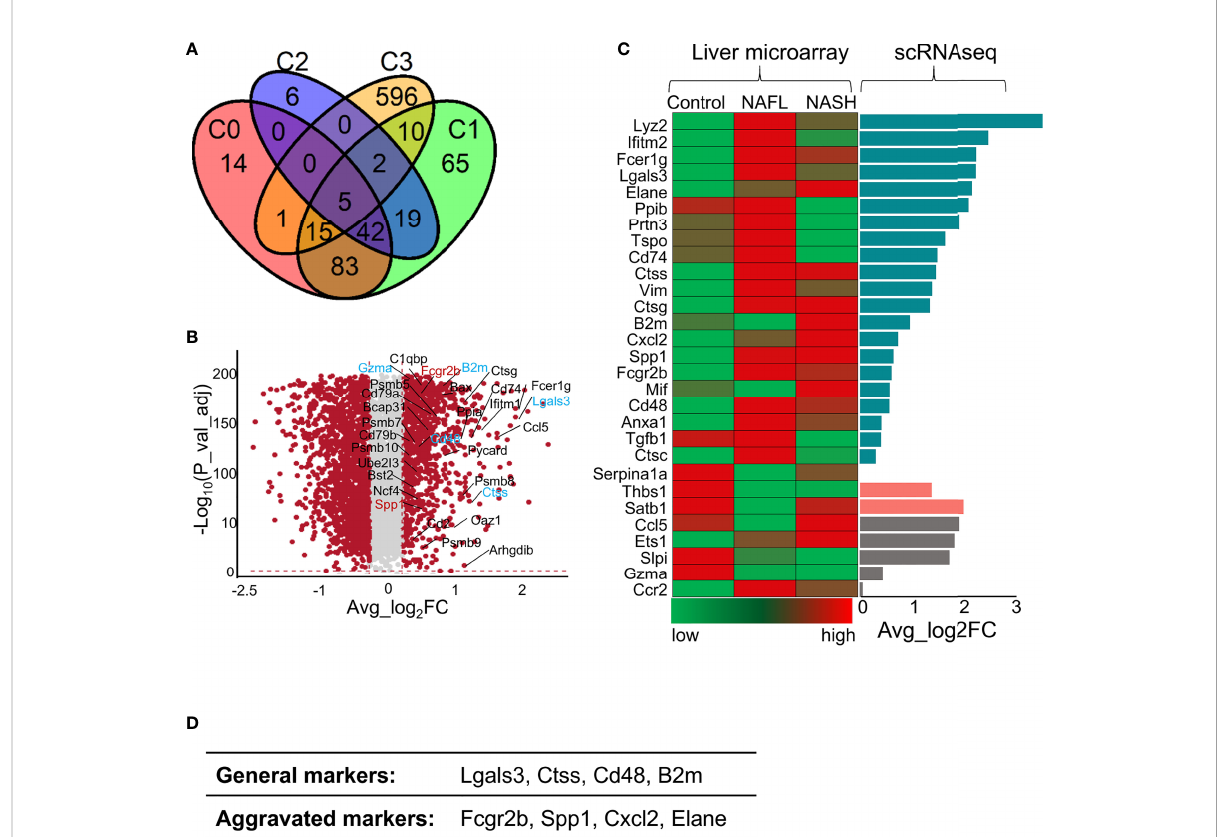
FIGURE 6 Comparison of gene pro fi le alterations during human NAFLD pathogenesis with mouse NAFL regulated by ApoA4 de fi ciency. (A) Venn diagram showing the overlap of upregulated genes identi fi ed in the KO group with genes identi fi ed in a cohort study by Michael et al. (2020) (36) ( P = 3.7e-11), as determined by a hypergeometric test. C0 was a set of differentially expressed genes between healthy controls and patients with mild liver steatosis, while C1 included genes upregulated in advanced liver steatosis compared with healthy controls. C2 consists of differentially expressed genes between patients with mild and advanced liver steatosis. C3 was upregulated in the KO group in this study. (B) Volcano plot showing differentially expressed genes in the KO group vs. WT group. Red dots indicate genes passing our P value -adjust and fold difference thresholds. Thirty-two genes that were crossed between C1 and C3 are marked with gene names, genes crossed between C2 and C3 are colored blue, and genes crossed among C1, C2 and C3 are colored red. (C) Comparison of the expression of genes of interest between NAFLD datasets (GSE63067) (left) obtained by liver microarrays and the data from this study obtained by scRNA-seq (right); Average_log 2 fold change > 0 in dark green, Average_log 2 fold change (KO vs. WT) < 0 in rose- Bengal. The gene expression patterns in patients from control to NAFL and NASH were inconsistent with our DEGs identi fi ed by scRNA-seq in grey. (D) The proposed universal NAFLD markers both in humans and in